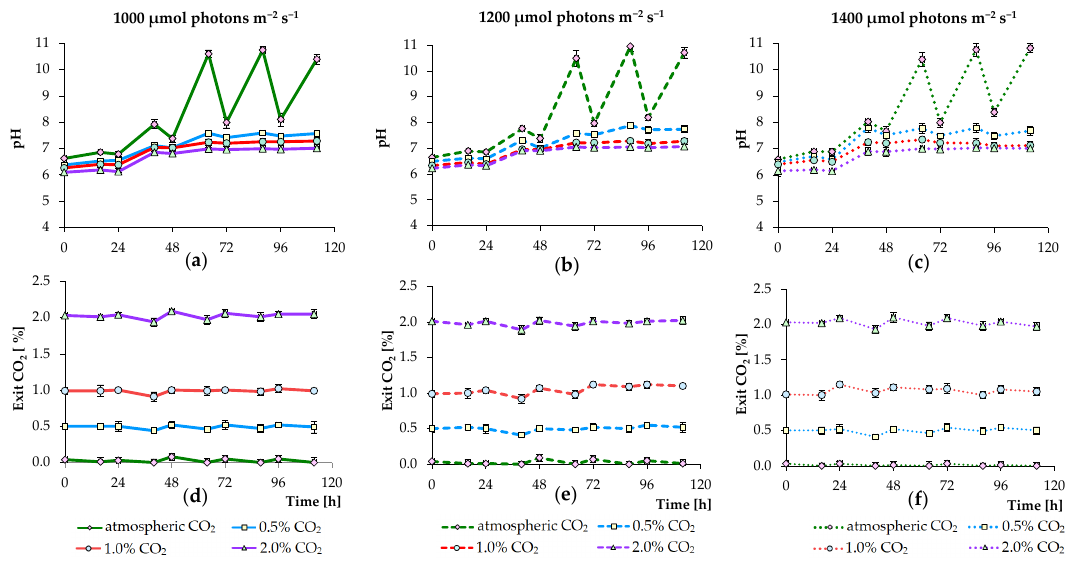
Figure 3. Changes in culture medium pH ( a – c ) and the released carbon dioxide level ( d – f ) observed during the growth of C. sorokiniana AM-02 cultured under various light and CO 2 regimens (1000, 1200, and 1400 µ mol photons m − 2 s − 1 and atmospheric CO 2 , 0.5, 1.0, and 2.0% CO 2 ) in standard BBM.